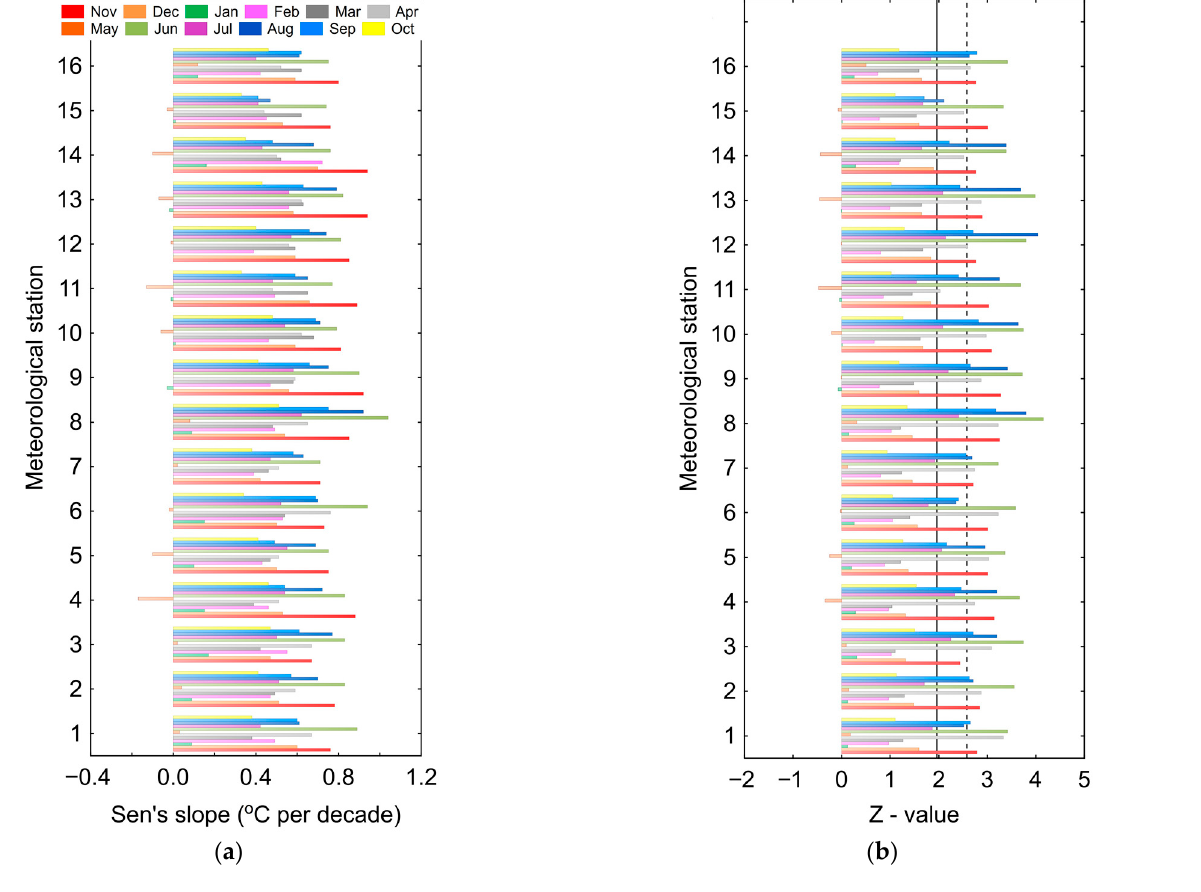
Figure 3. Changes in mean monthly air temperatures: ( a ) Rate of changes in °C per decade and ( b ) significance of the changes (solid line—significance level of 0.05, dashed line—significance level of 0.01).